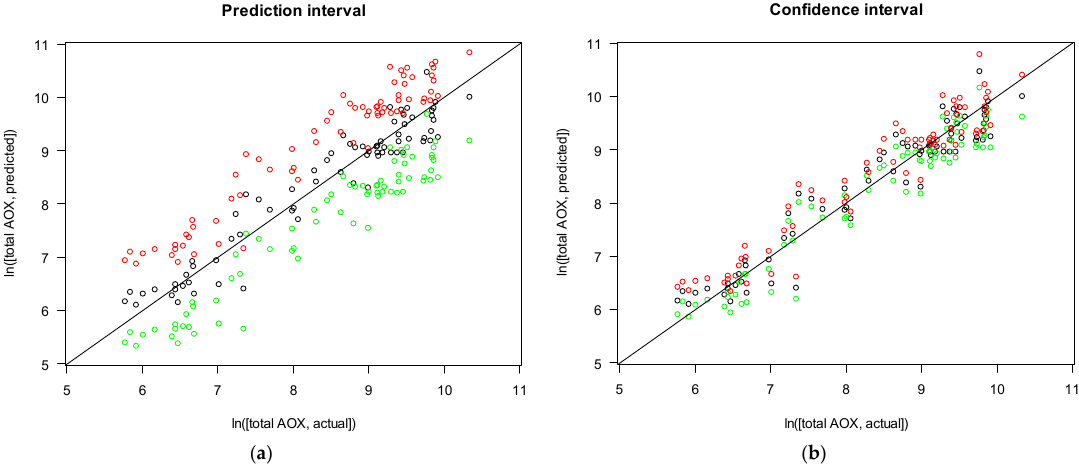
Figure 6. Prediction interval ( a ) and confidence interval ( b ) per observation for the model predicting the total AOX concentration (minimum points are indicated in green, maximum points in red, and fitted points in black).